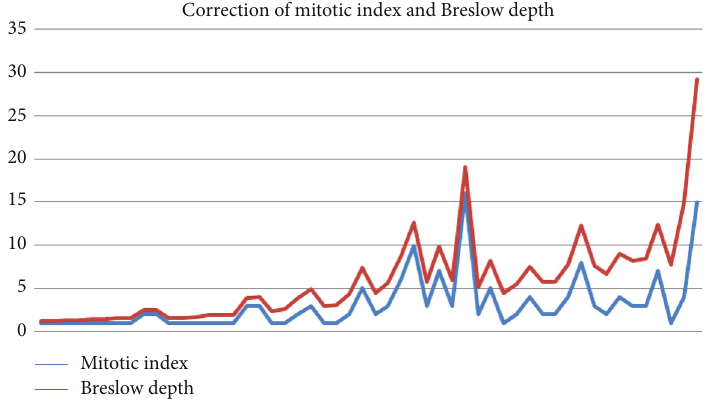
Figure 2: Correlation of the most important prognostic factor in melanoma.